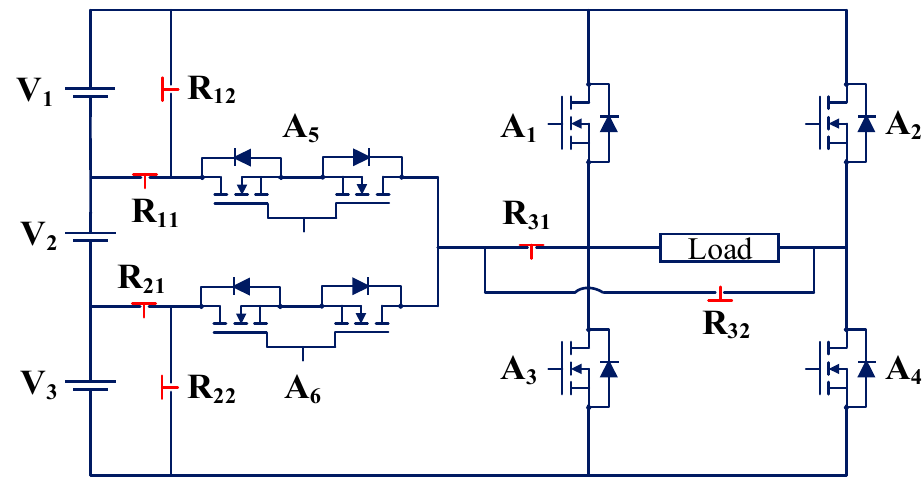
Figure 38. Single-phase seven-level FT MLI (TP41) [73].